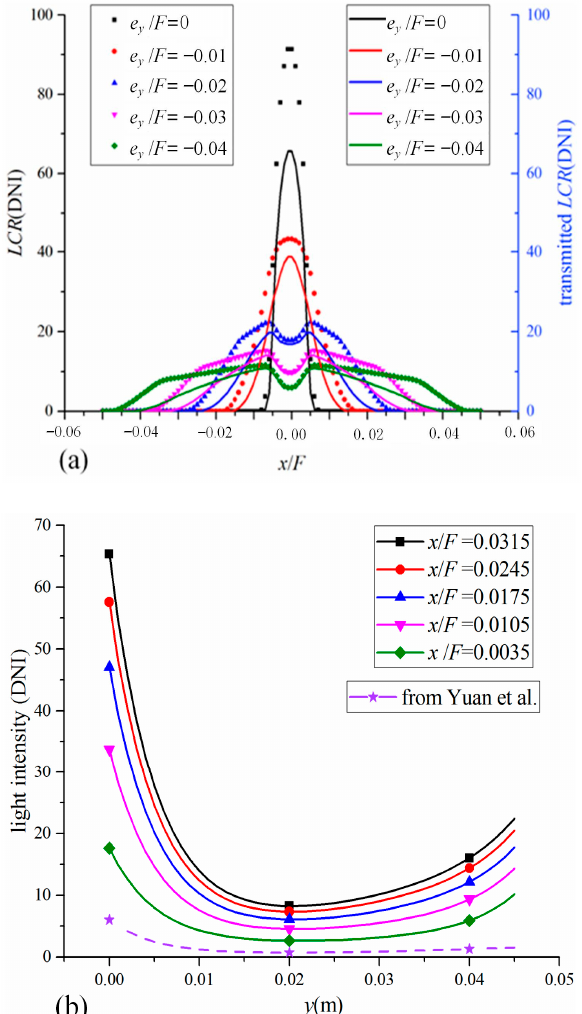
Figure 8. The variations of ( a ) concentrated irradiative flux on monolith with x coordinate normalized by the focal length of different alignment errors and ( b ) irradiative flux on the reaction wall with y coordinate of different reaction channels.